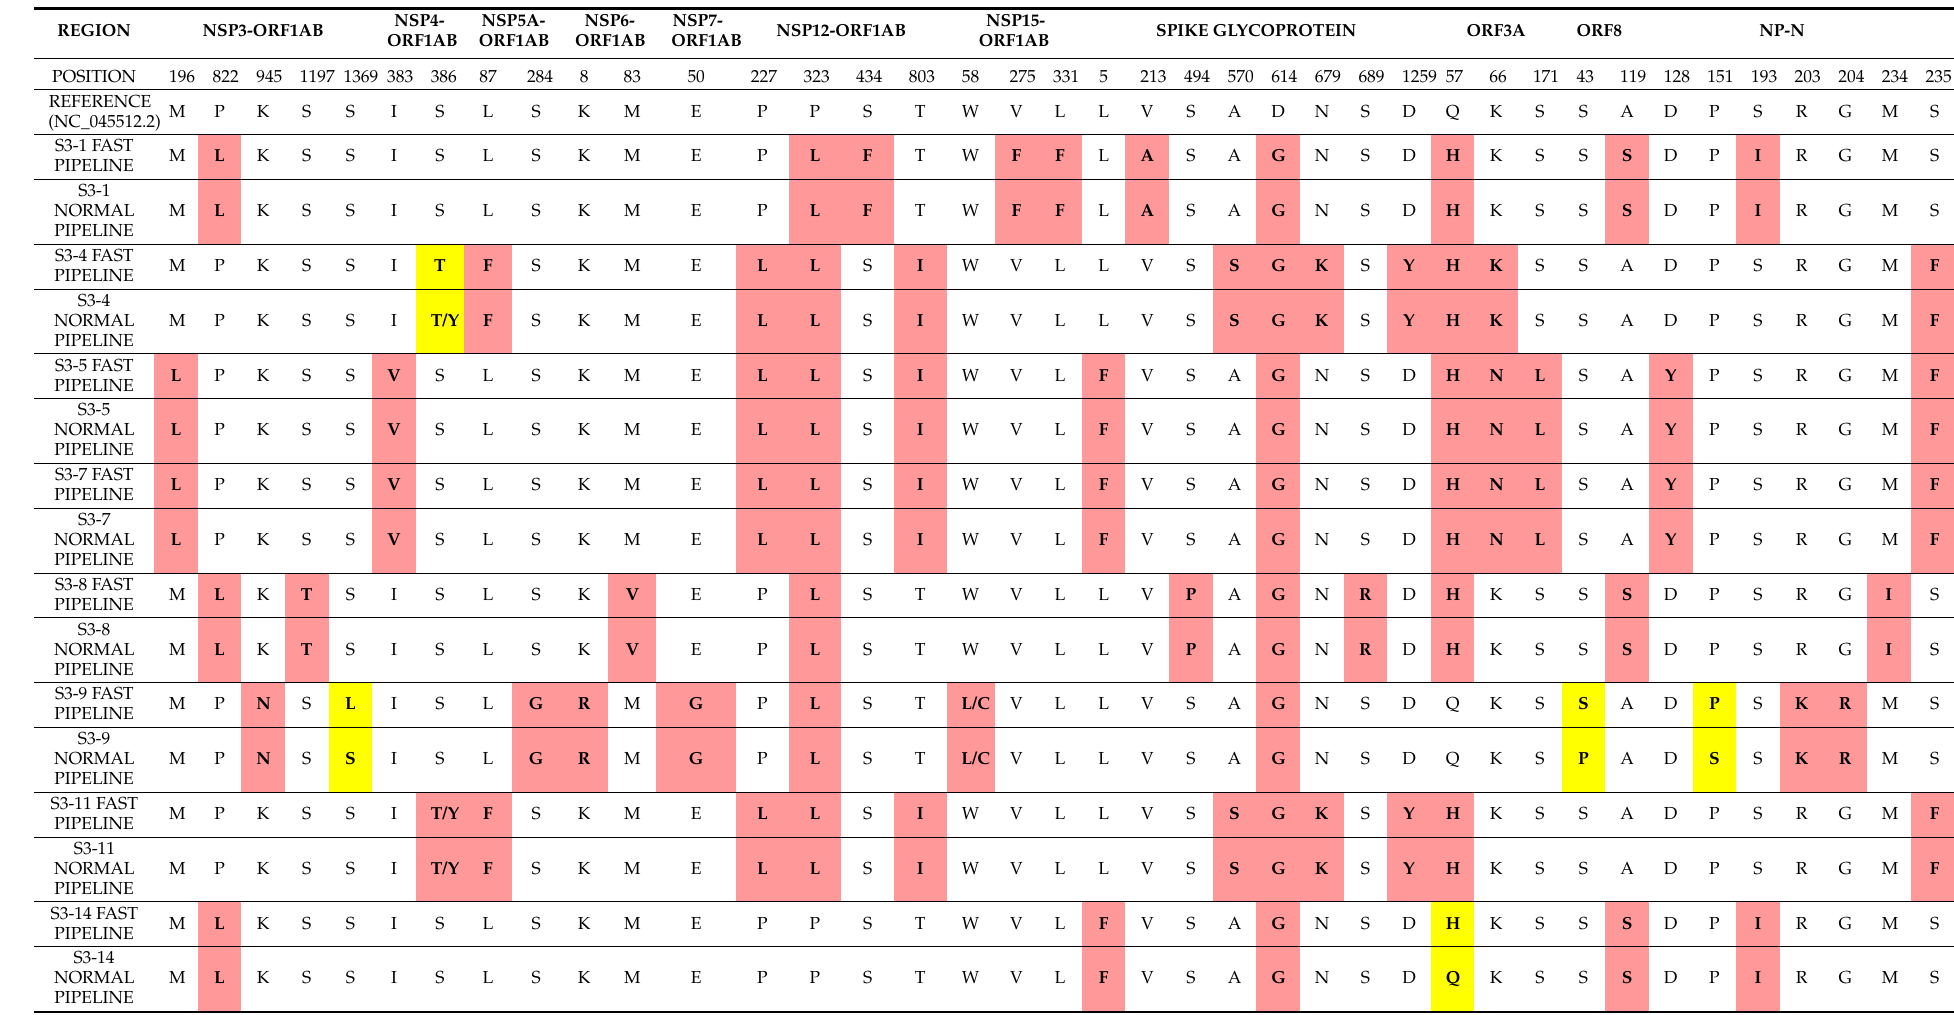
Table 14. Identified Amino Acids Mutations in Batch 3 Samples Running All